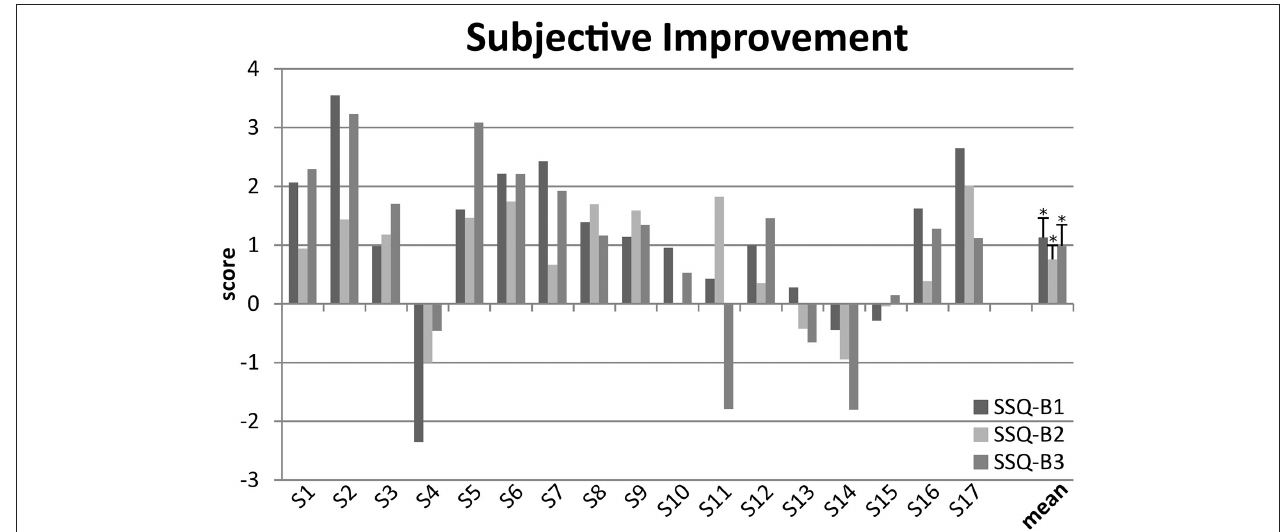
FIGURE 1 | Individual and mean self-reported improvements assessed with the SSQ-B at T4 for speech comprehension (SSQ-B1), sound localization (SSQ-B2) and sound quality (SSQ-B3). Individual means (S1–S17), and group means together with their standard errors are shown for each of the SSQ-B1-3 scales. Group means evidence improvements that are significantly different from 0 (* p <